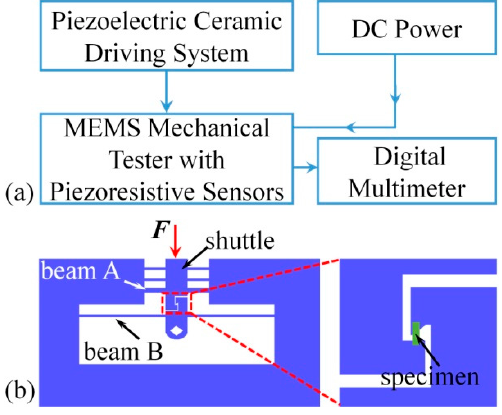
Figure 1. Schematic of the testing system in scanning electron microscopes (SEM): ( a ) the actuation control flow chart; and ( b ) design of the testing apparatus.